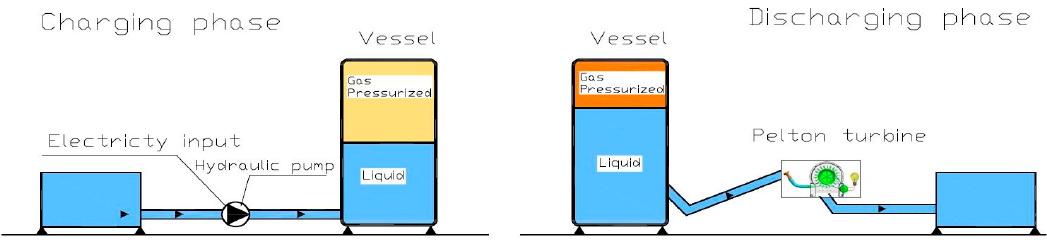
Figure 1. Scheme of the Energy Storage System.